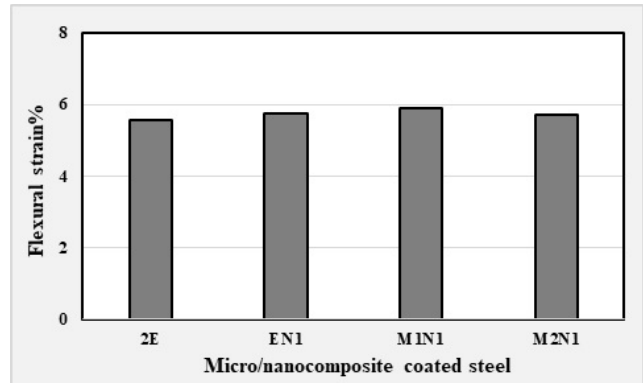
O micro/nanoparticles. 2 3